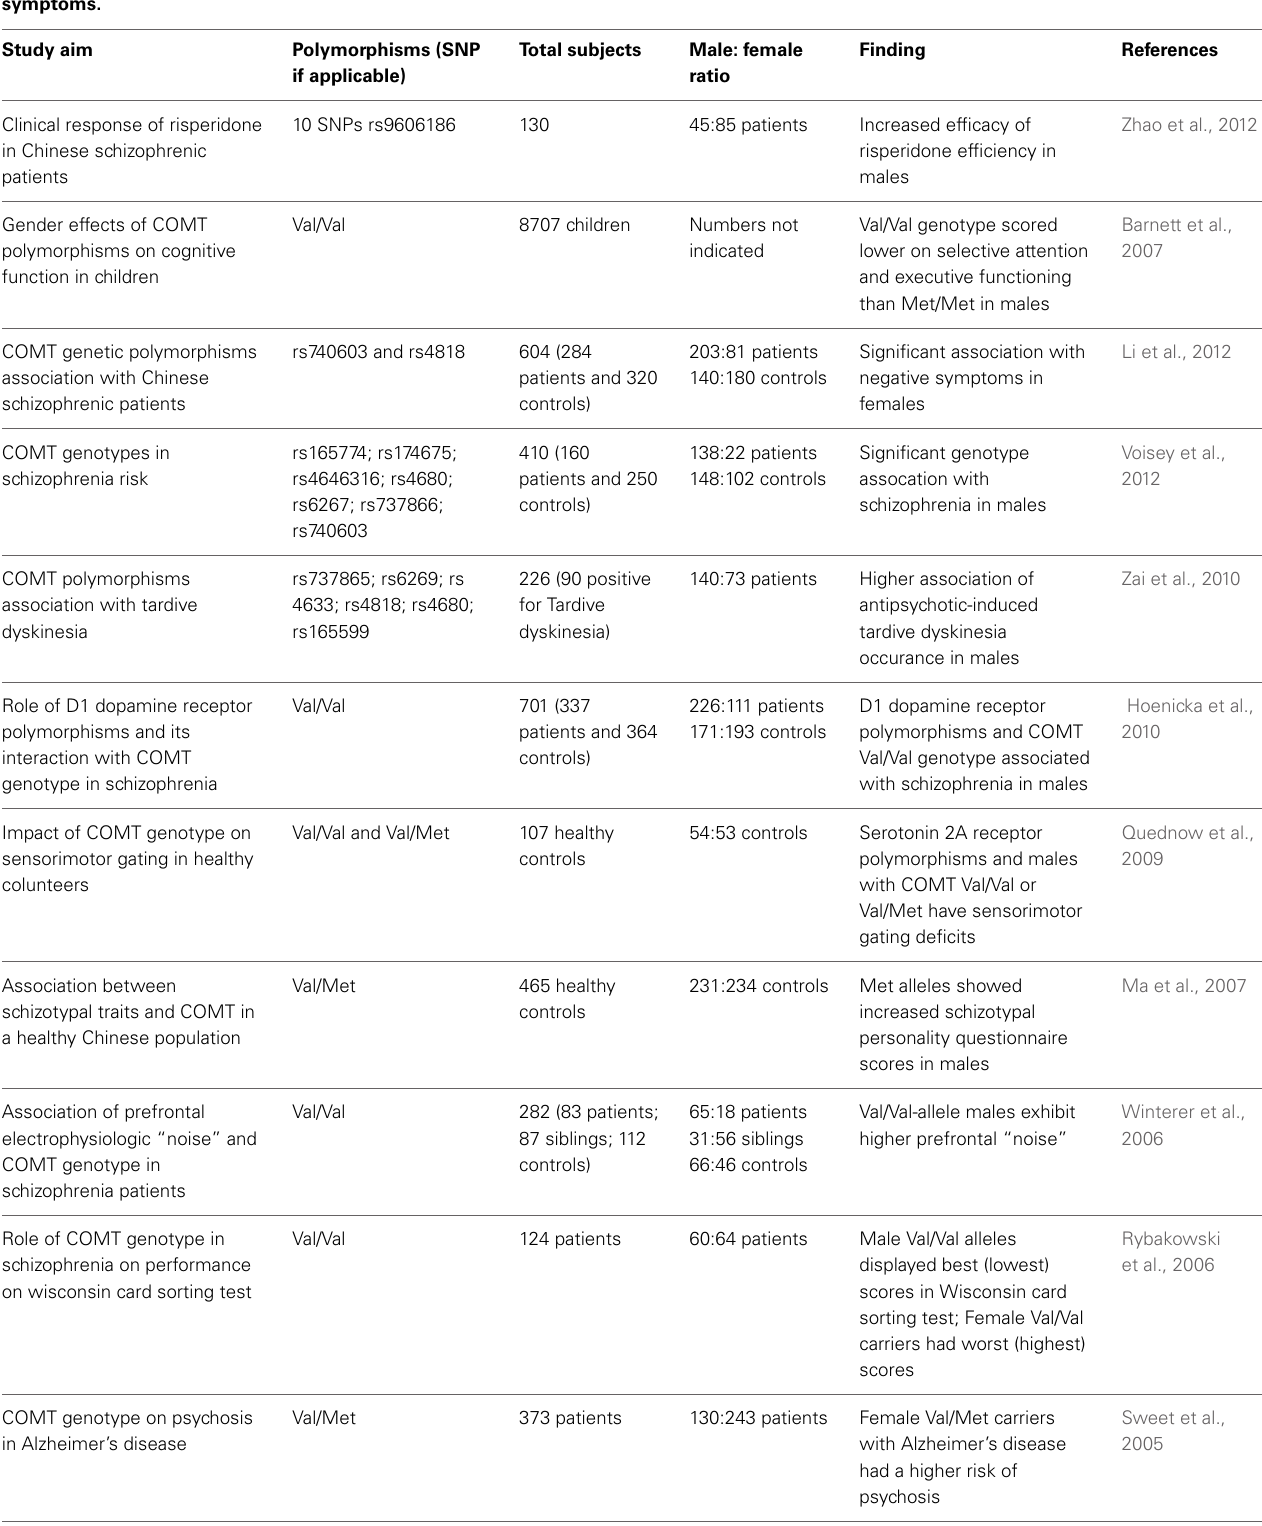
Table 1 | List of major studies documenting an interaction between COMT polymorphic variants and sex in schizophrenia and related